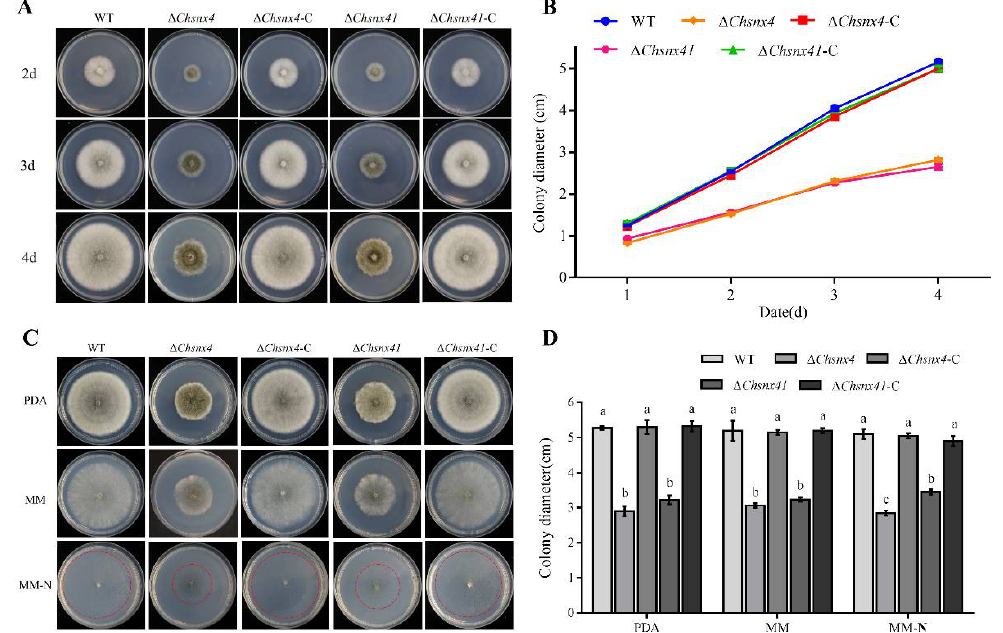
Figure 2. Cochliobolus heterostrophus Snx4 and Snx41 are required for colony growth on CMX (CMX: complete medium, glucose was replaced by xylose), PDA, MM, and MM-N. ( A ) Colony morphology of WT, ∆ Chsnx4 , ∆ Chsnx4-C , ∆ Chsnx41 , and ∆ Chsnx41 -C grown on CMX for 4 days. ( B ) Statistical analysis of the colony diameter of indicated strains on the 4th day. ( C ) Colony morphology of WT, ∆ Chsnx4 , ∆ Chsnx4-C , ∆ Chsnx41 , and ∆ Chsnx41 -C grown on PDA, MM, and MM-N. ( D ) Statistical analysis of colony diameter on PDA, MM, and MM-N. Each experiment had three replicates and was repeated three times.